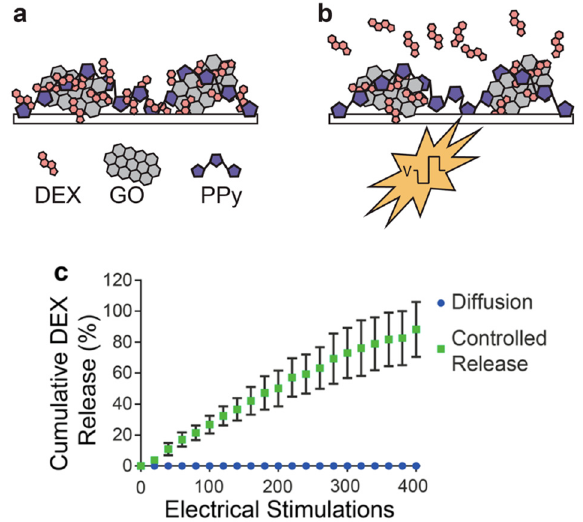
Figure 11. Illustration of GO/PPy-DEX nanocomposite ( a ) and its DEX release ( b ) after electrical stimulation. ( c ) Cumulative release of the nanocomposite for up 400 pulses, without electrical stimulation no drug release was observed. Adapted from reference [184].